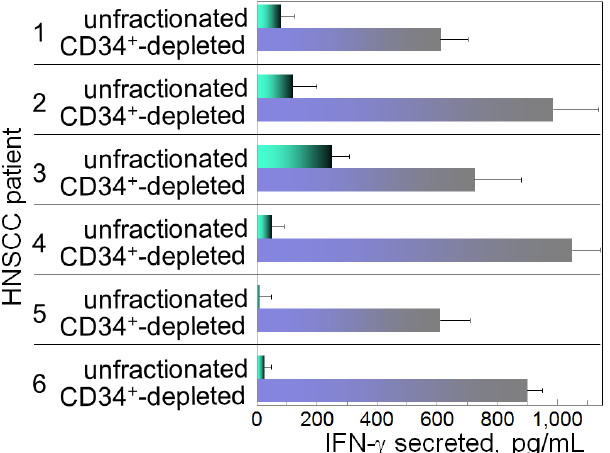
Figure 2. Inhibition of IFN-  production in the presence of patients’ CD34 +